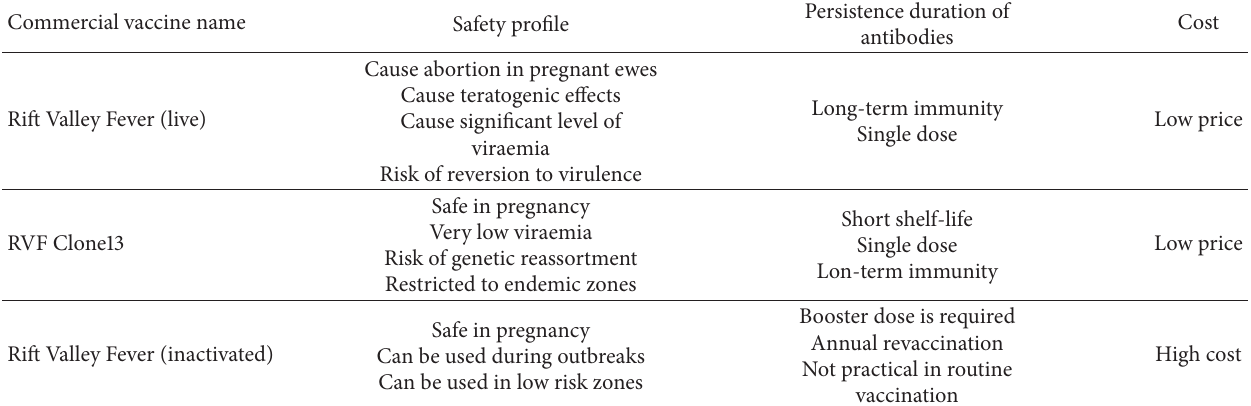
Table 3: Safety and efficacy profile of commercial vaccines against RFV